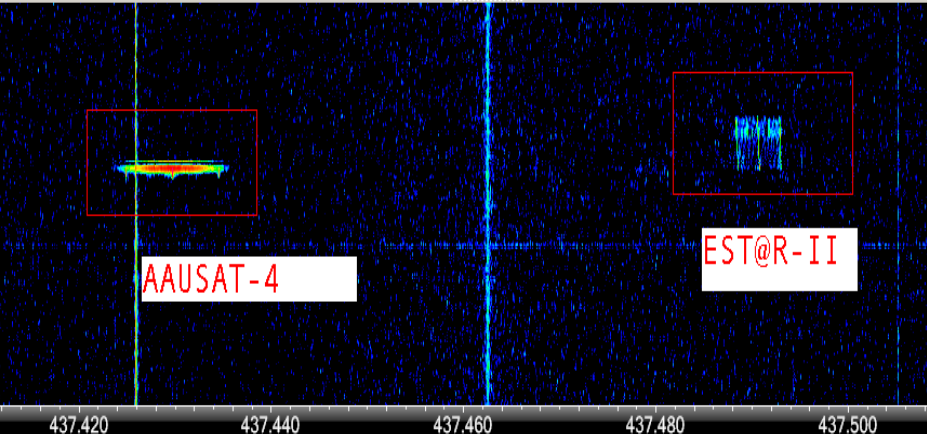
Figure 3. Comparison between AAUSAT-4 and E-st@r-II signal strength .